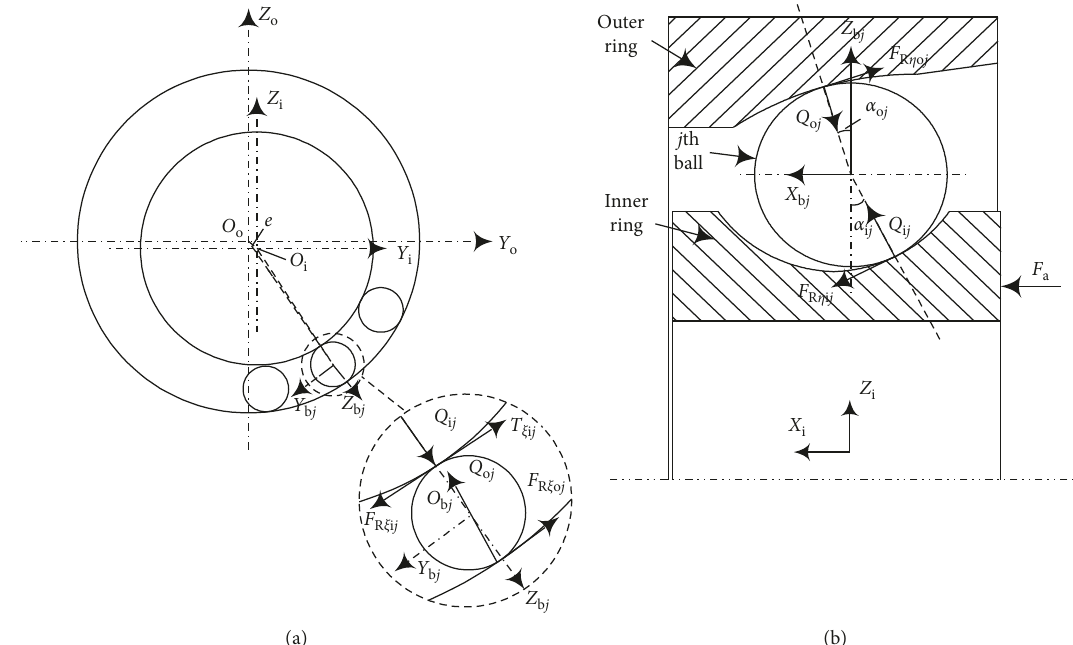
Figure 1: Contact model between balls and rings in the (a) YOZ plane and (b) XOZ plane.